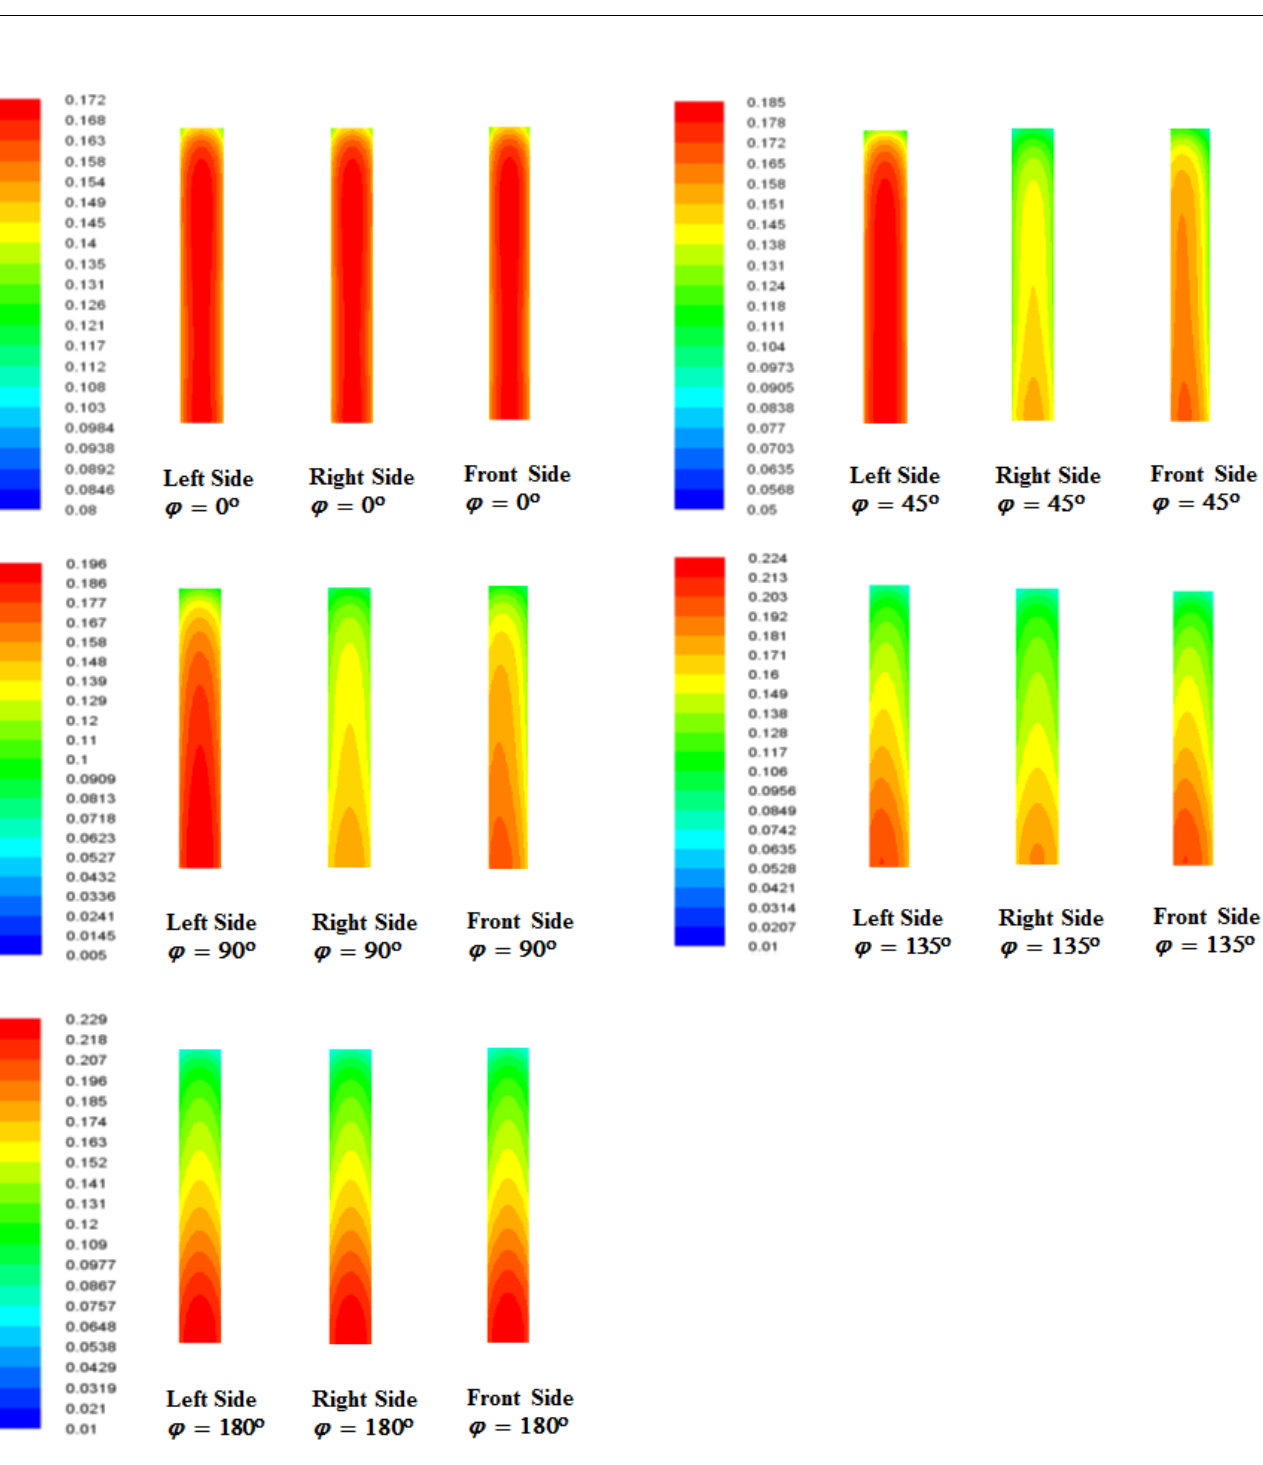
Figure 16. Variations in temperature distribution over the left-side, right-side, and front surfaces of the slender cuboid at different positions, φ , when Ra * = 1 × 10 4 and W = 0.15.